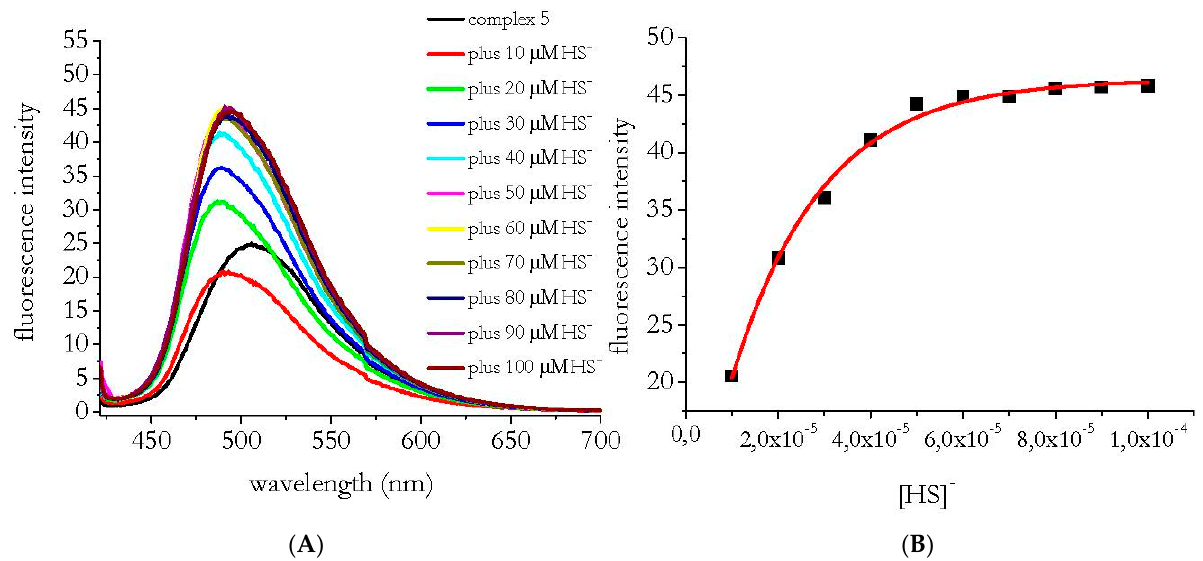
Figure 5. ( A ) Emission spectra of complex 5 ( λ exc = 410 nm) when titrated with NaSH. [Complex 5 ] = 1 × 10 − 5 M; end concentration of NaSH varied in the range (1–10) × 10 − 5 M. ( B ) The fluorescence intensity values of complex 5 with NaSH at 490 nm shown in this figure fit against HS −